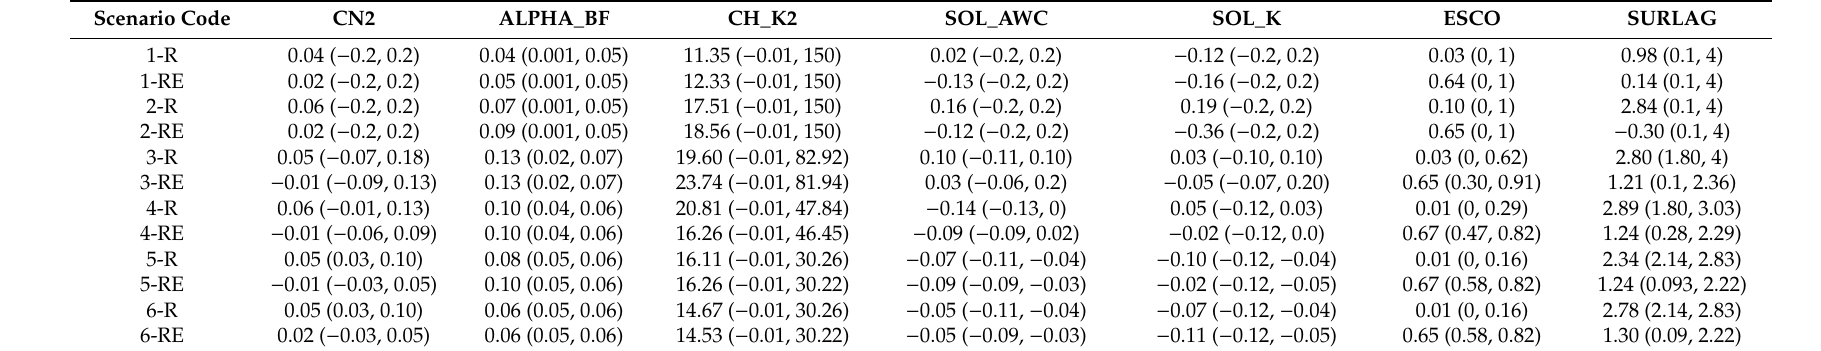
Table 5. Final optimal parameter values and